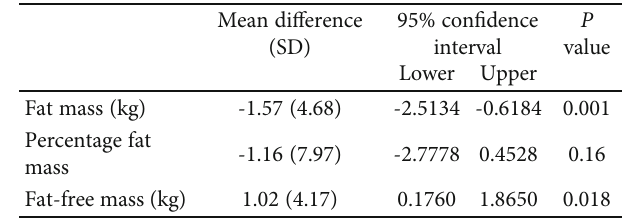
Table 1: Descriptive data of 97 study participants. Variable